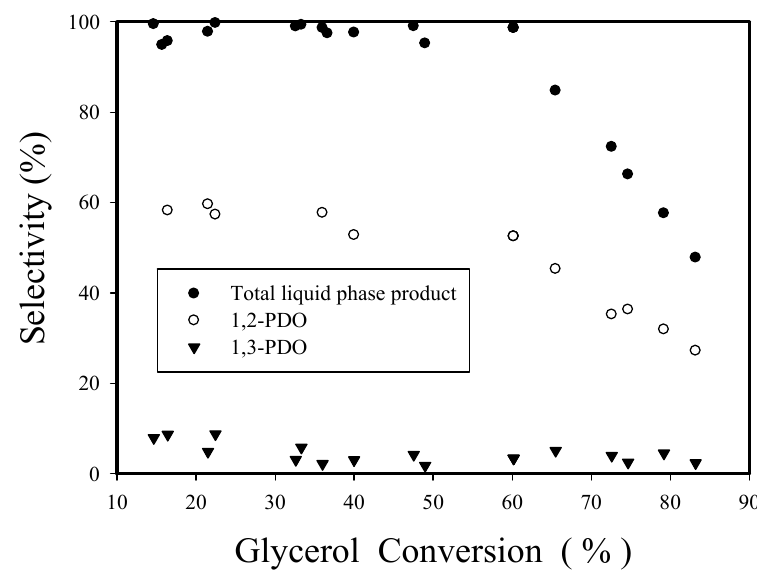
Figure 13. Influence of glycerol conversion on selectivities to overall liquid-phase product, 1,2-PDO and 1,3-PDO for Re-08RuSi catalyst.